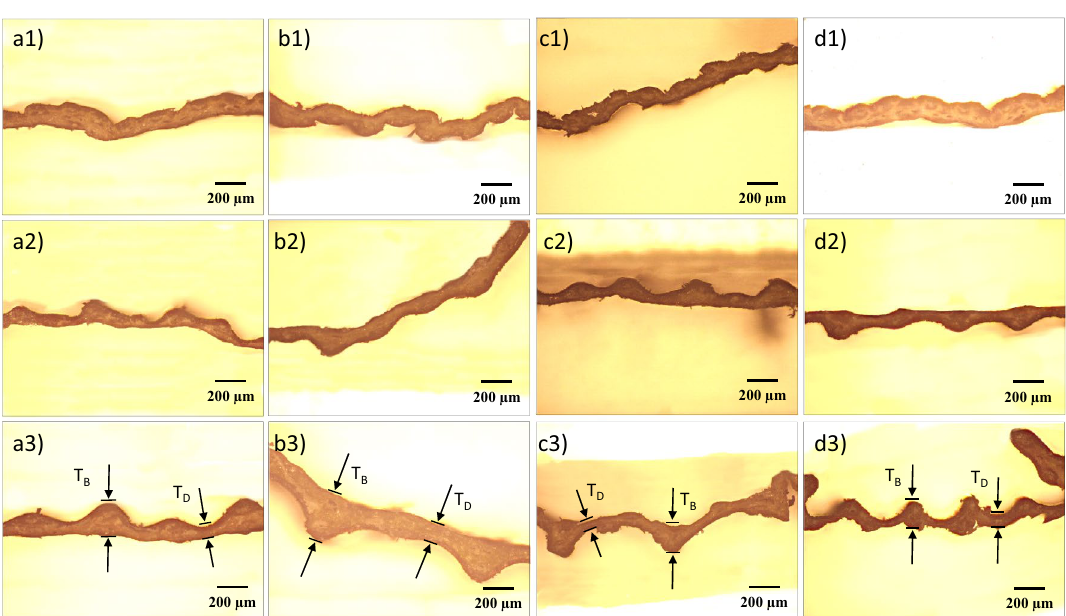
Figure 3. The cross section morphologies of culm wall for ( a ) R1, ( b ) R2, ( c ) R3, and ( d ) R4. The numbers 1, 2, and 3 indicate that the morphologies were taken from the top, middle and bottom of the culm wall, respectively. Examples for the bulge region and the depressed region have been marked with arrows and